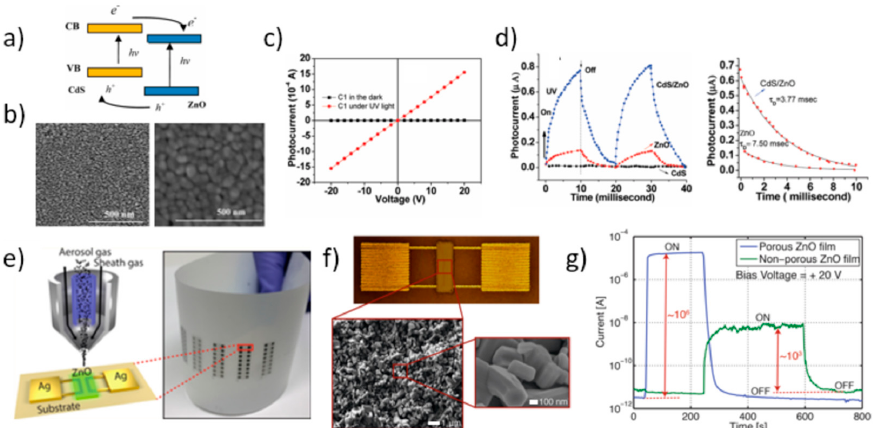
Figure 16. Applications in ultraviolet (UV) photodetection. (a) Sketch of the energy diagram of the CdS/ZnO nanocomposite indicating interfacial charge-transfer. (b) Top-view SEM micrograph of the pure ZnO film (left panel) and of the CdS NP dip-coated film (right panel) (precursor of 0.0125 M concentration, 5 dip cycles). (c) Current-voltage characteristics of CdS/ZnO film (CdS precursor concentration of 0.0125 M, 5 dip cycles) under dark and UV irradiation conditions (black and red symbols, respectively). (d) Photoresponse vs. time under UV irradiation “on” and “off” conditions for the CdS capped ZnO device compared to pure ZnO film and CdS film (left panel; blue, red, and black symbols, respectively). Magnification of the decay process for the CdS/ZnO nanocomposite and ZnO films (right panel). Reprinted with permission from Reference [126]. Copyright 2010 American Chemical Society. (e) Schematic diagram of the aerosol jet deposition head as printing the device architecture on the PET substrate: the conductive Ag contacts, and the ZnO active layer (left panel). Optical image of the whole flexible substrate patterned with an array of printed thin film ZnO photodetector elements (right panel). (f) Microscopic image of the device and SEM image of the ZnO films at different magnifications. (g) Photocurrent vs. time under switched “on” and “off” 252 nm UV light irradiation from printed photodetectors with porous and non-porous ZnO film. Reprinted with permission from Reference [131]. Copyright 2018 American Chemical Society.